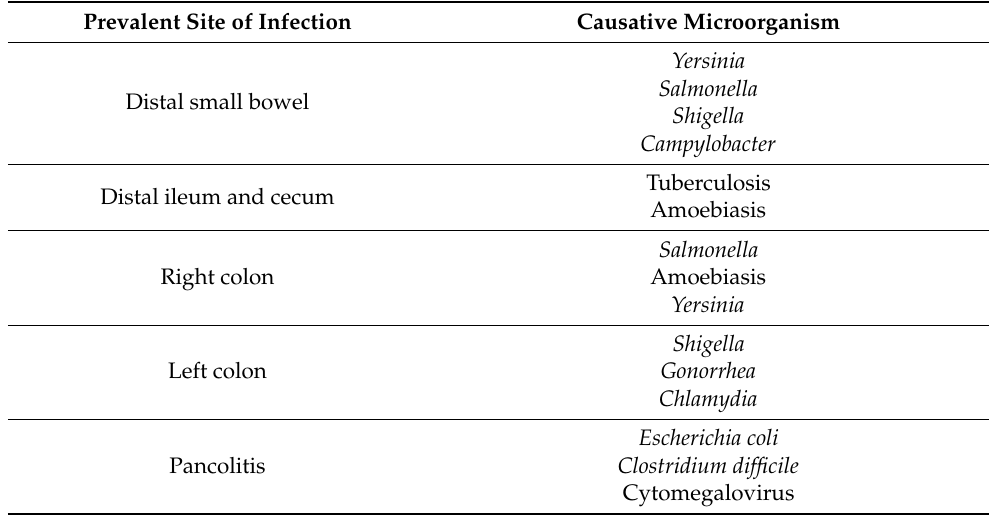
Table 1. Prevalent sites of infectious enterocolitis according to the causative microorganism. Prevalent Site of Infection